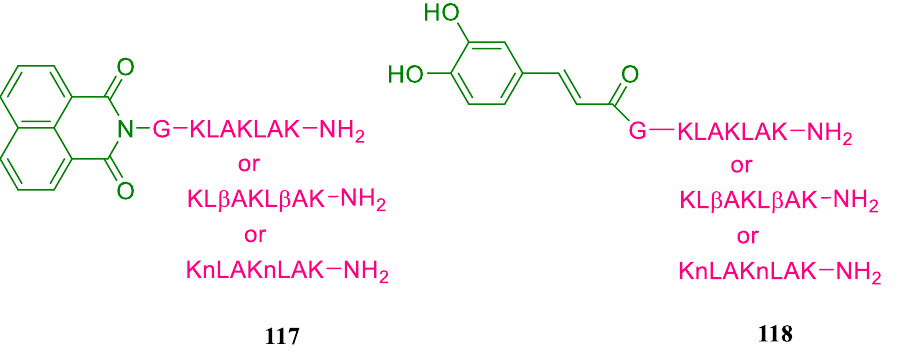
Figure 96. Analogues of (KLAKLAK) 2 -NH 2 and their derivatives.